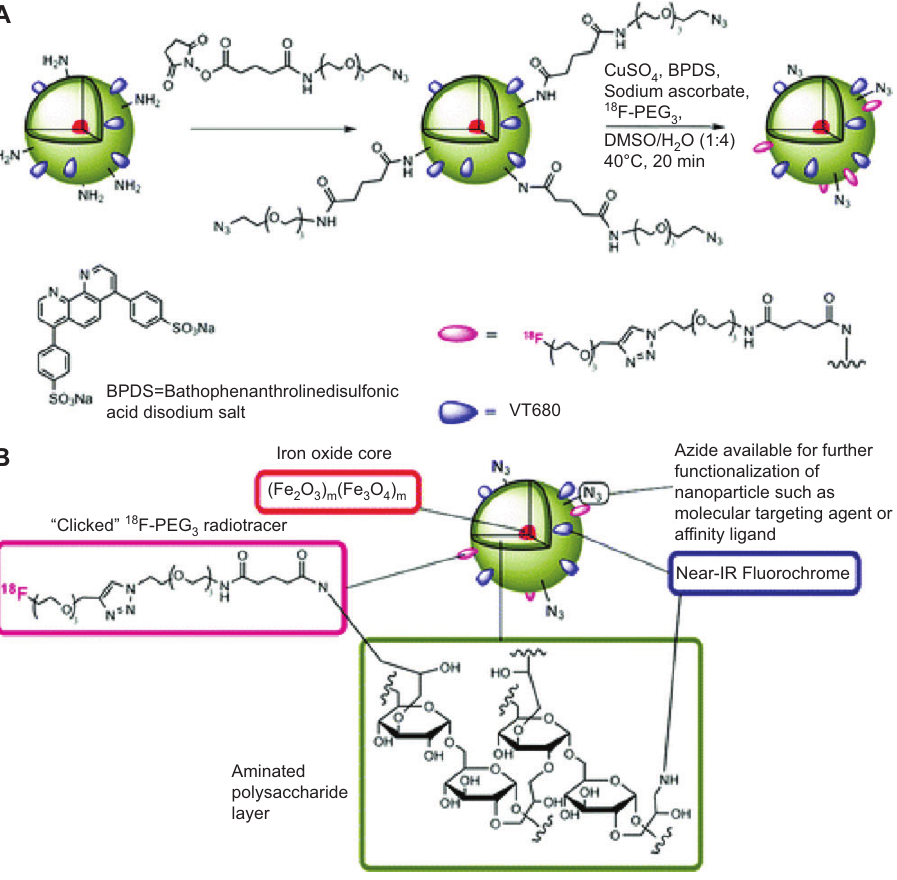
Figure 3 Preparation of 18 F-CLIO. (A) Derivatization of primary amines on CLIO-VT680 with the NHS ester of 1-azido-13-oxo-3,6,9-trioxa-12-azaheptadecan-17-oic acid followed by chemoselective “ click ” of 18 F-PEG3 radiotracer. (B) Schematic of 18 F-CLIO [41] . Permission/license was obtained from RightsLink;